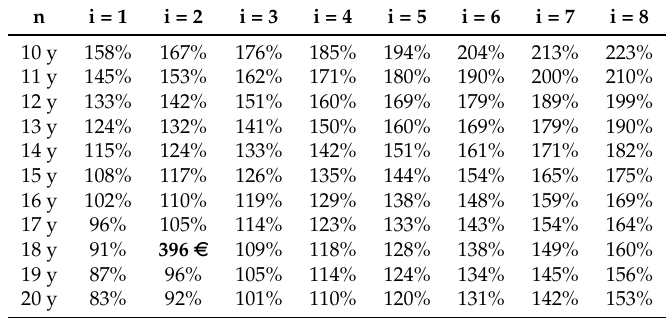
Table A5. PV system annuity sensitivity—Variation of interest rate and depreciation time of a PV system with 5 kWp compared to the initial values (n = 18, r = 2) (shown in bold).